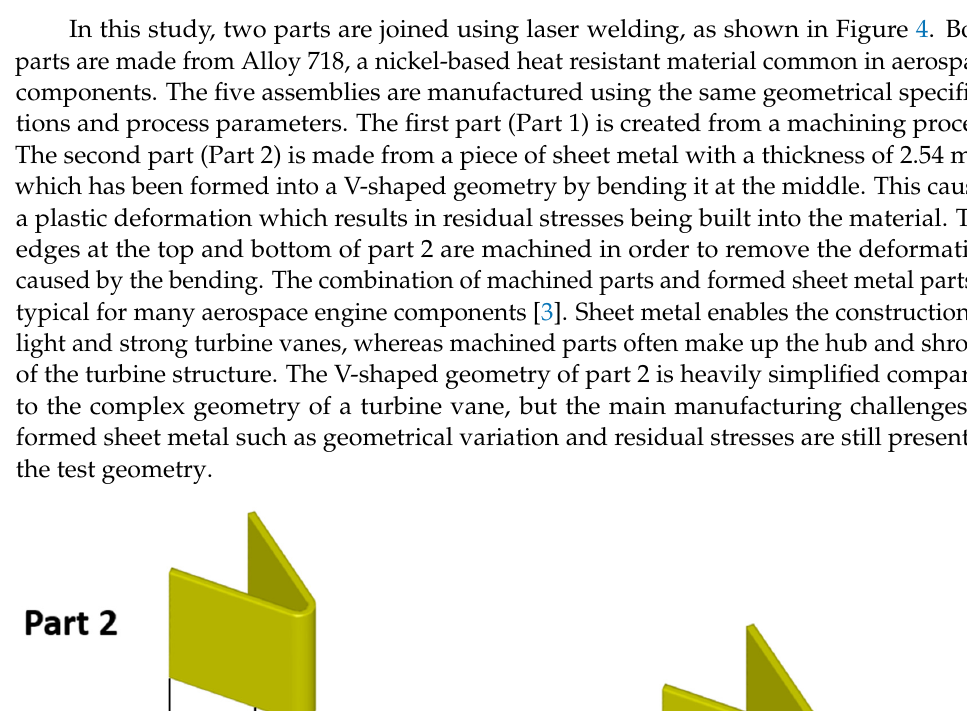
Figure 3. The scope of the case study in relation to the digital twin model.